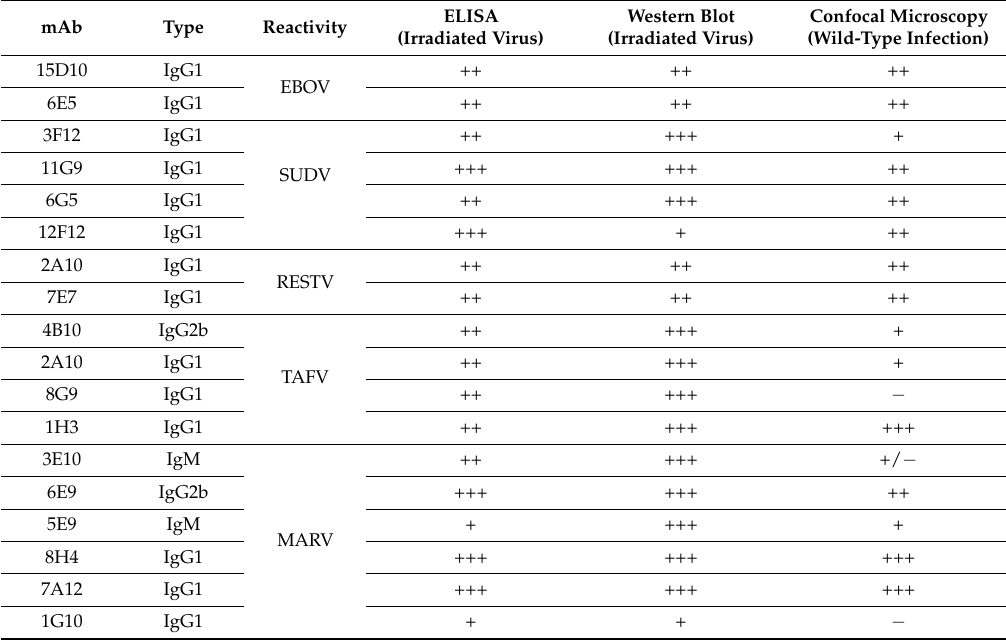
Table 2. Characteristics of anti-filovirus NP